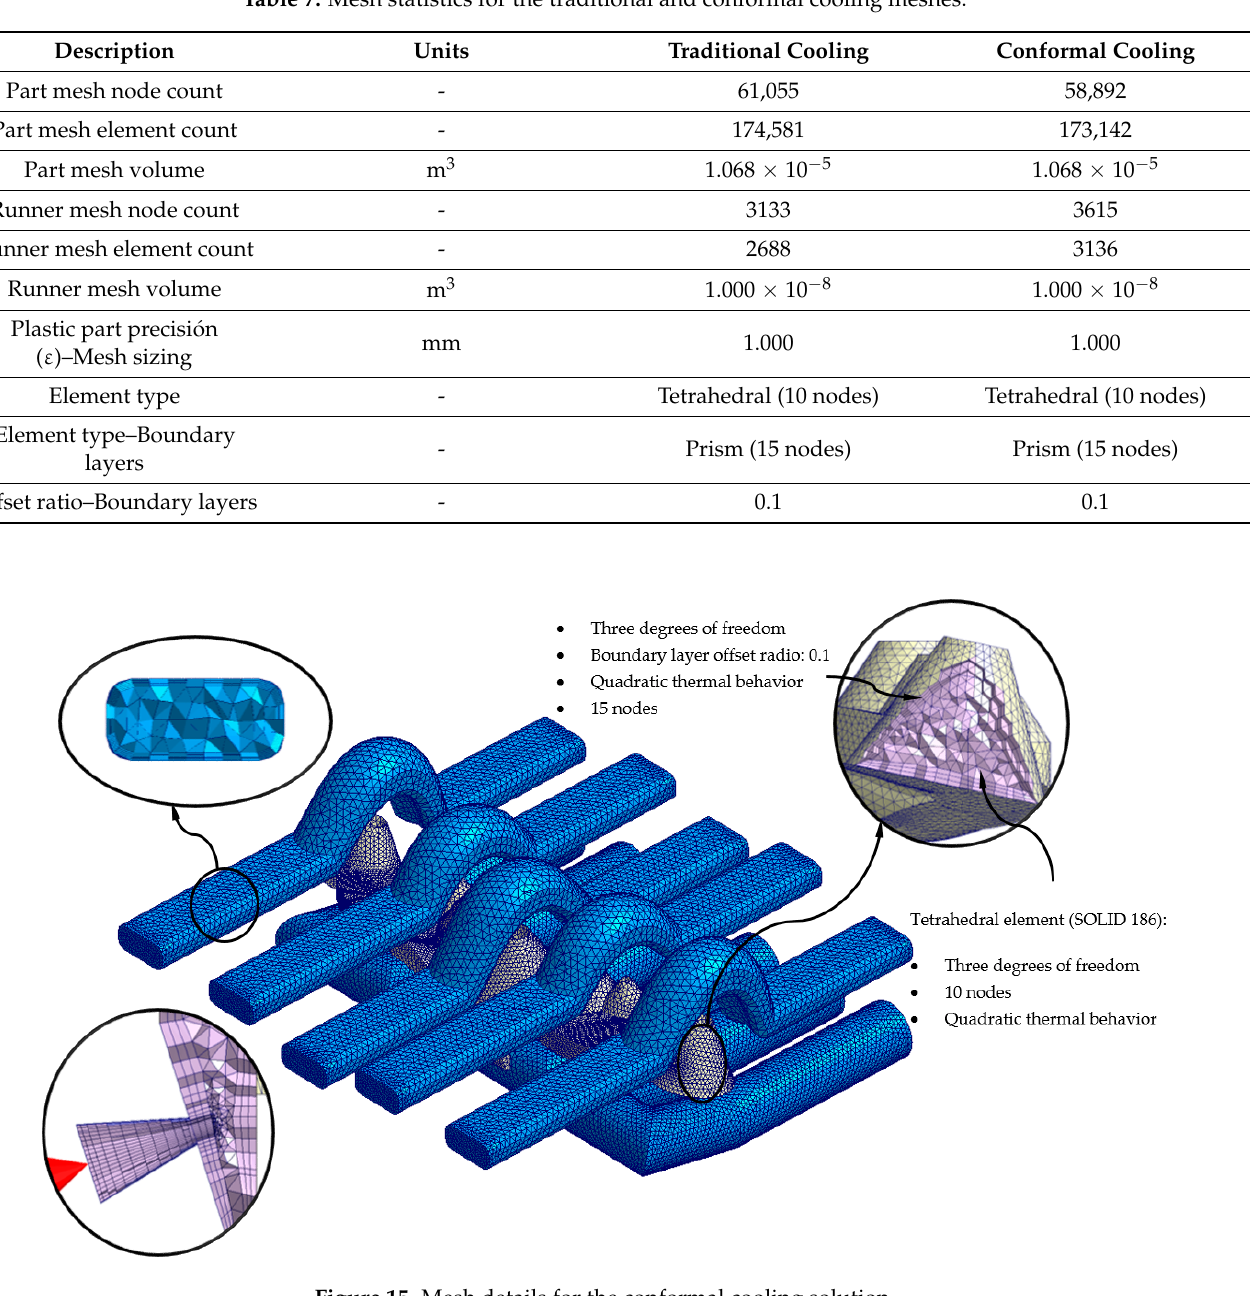
Figure 15. Mesh details for the conformal cooling solution.